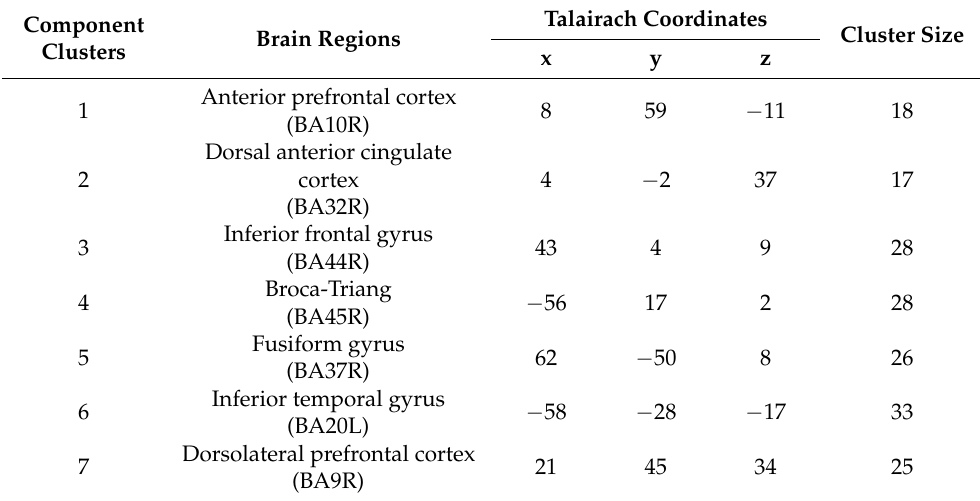
Table 1. The size of the clusters and their corresponding brain regions and Talairach